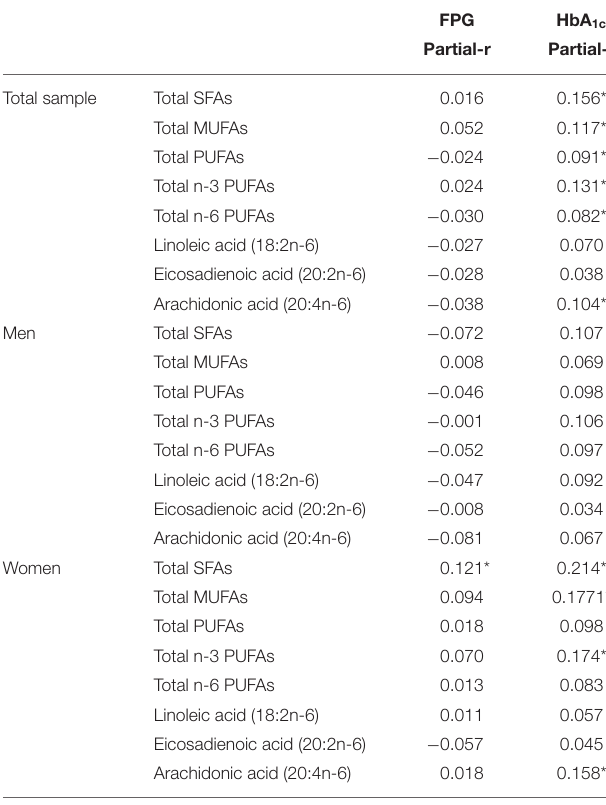
TABLE 3 | Spearman partial correlations between serum fatty acid biomarkers and FPG and HbA 1C stratified by sex.